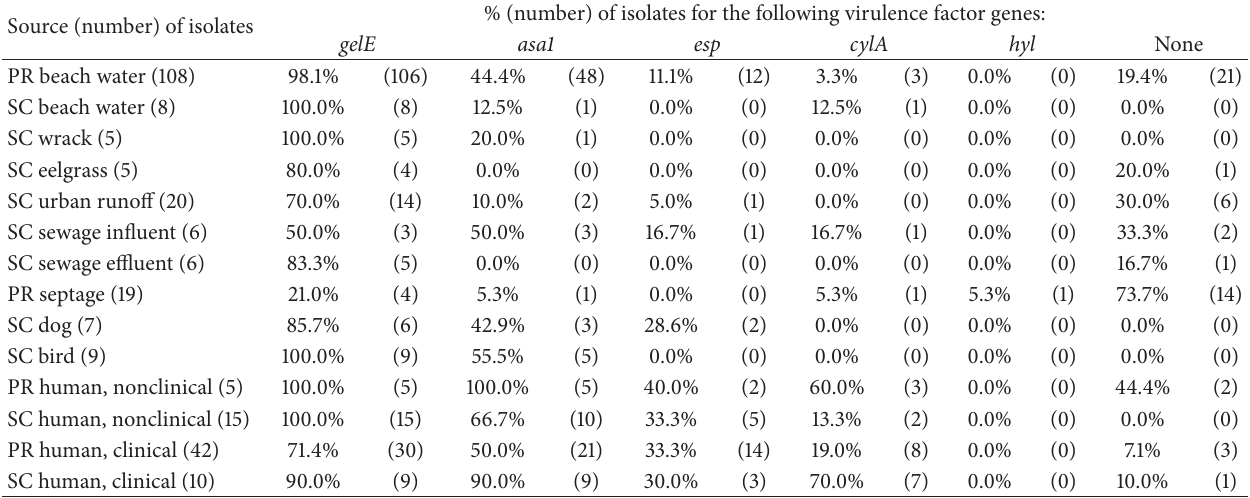
Table 3: Distribution of virulence factor genes among E. faecalis isolates from Southern California (SC) and Puerto Rico (PR). Source (number) of isolates